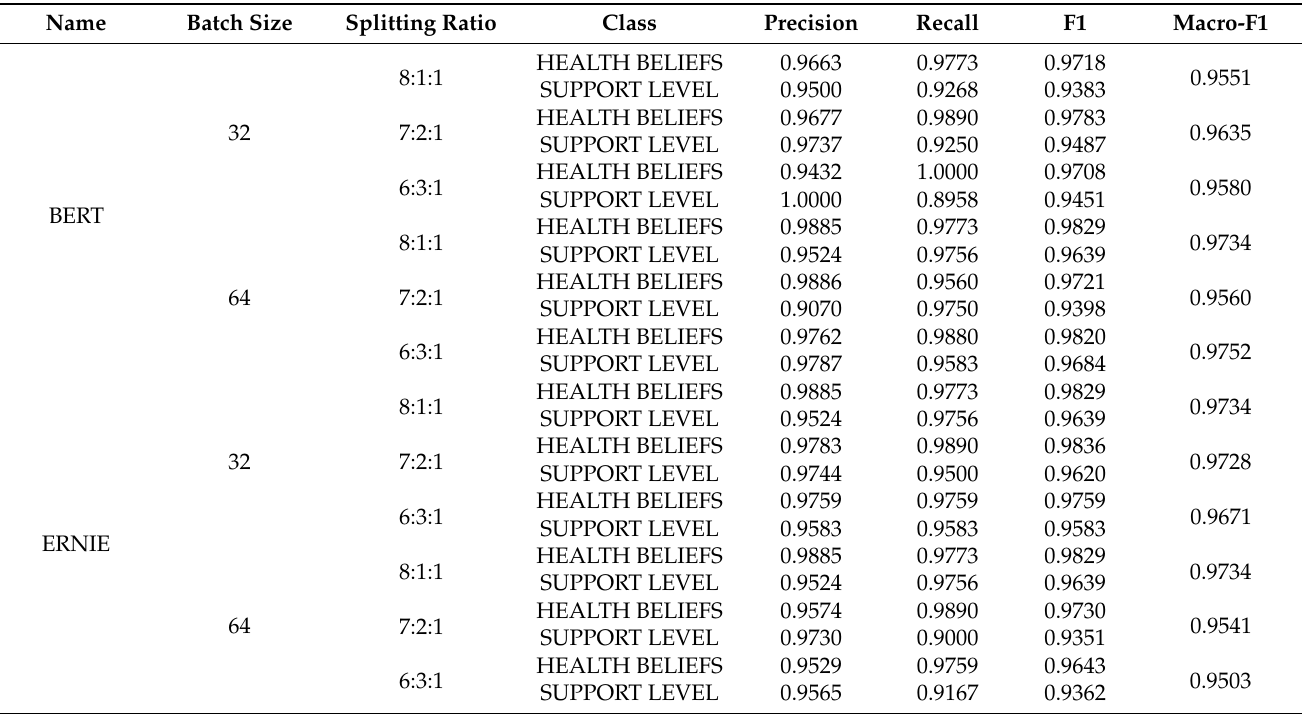
Table 6. Comparison of performance metrics by